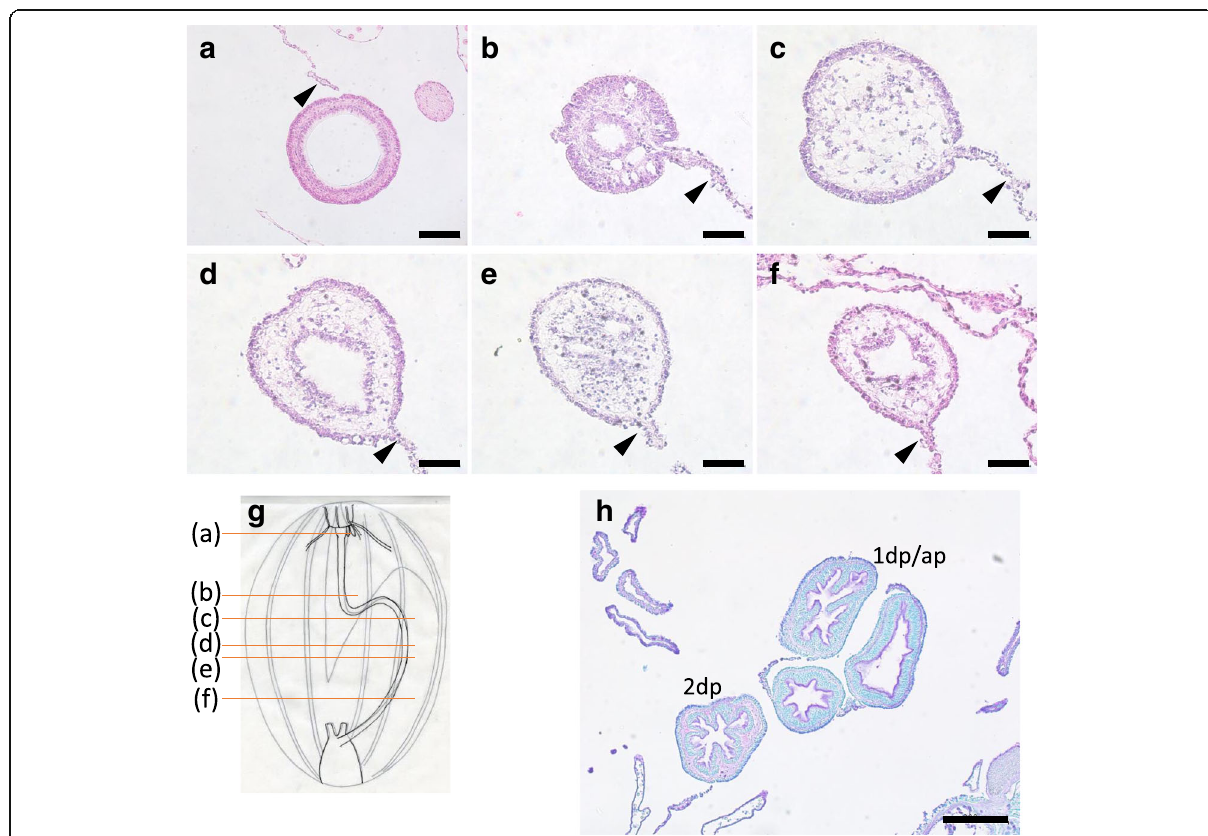
Fig. 8 Histology of the tissues at stage IV. Cross sections of the body at stage IV focusing on the regenerated digestive tract. Sections a - f were made at positions indicated in g , of a specimen at 17 dpe. h The middle part of the animal with 1st descending, ascending and 2nd descending intestines, at 20 dpe, stained with TB. The slice was made roughly between b and c in a further regenerated animal with a single tube throughout the digestive tract. The 1st descending and ascending intestines could not be distinguished, since the intestines meandered. 1st descending or ascending intestine; 2dp, 2nd descending intestine. Arrowheads indicate mesenteries. Scale bar 50 μ m in b - f ; 100 μ m in a ; 200 μ m in